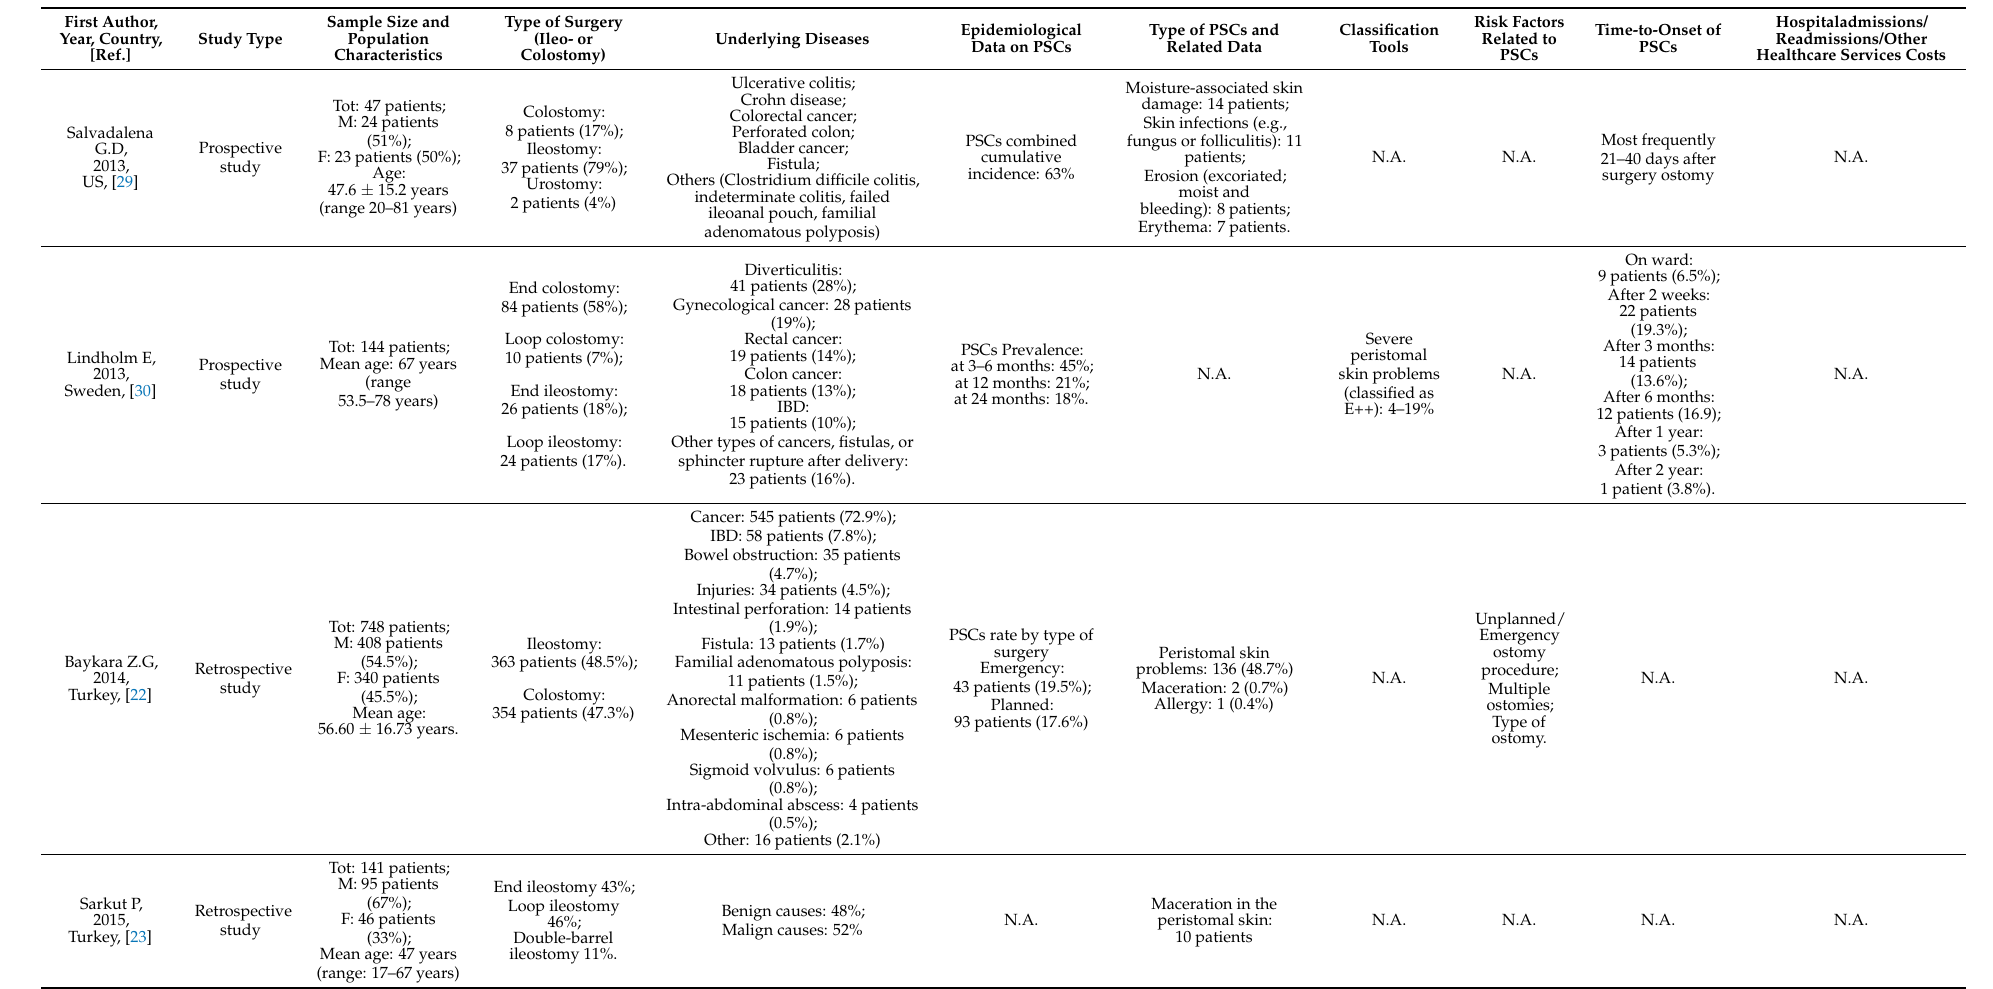
Table 2. Main characteristics and findings of the primary studies included in our systematic